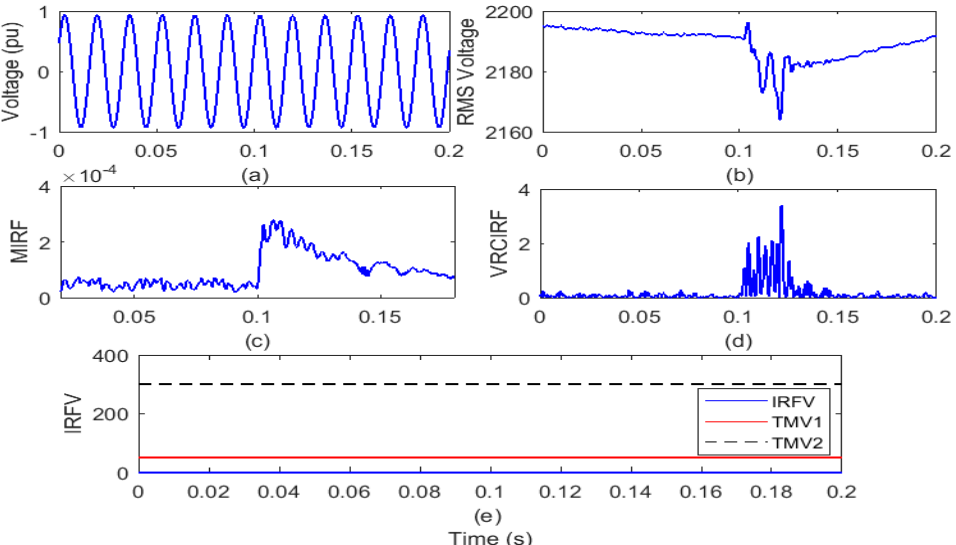
Figure 12. Outage of solar power plant from test grid ( a ) voltage signal ( b ) root means square value of voltage ( c ) median-based IRF ( d ) rate of change in voltage-based IRF ( e ) islanding recognition factor based on voltage.